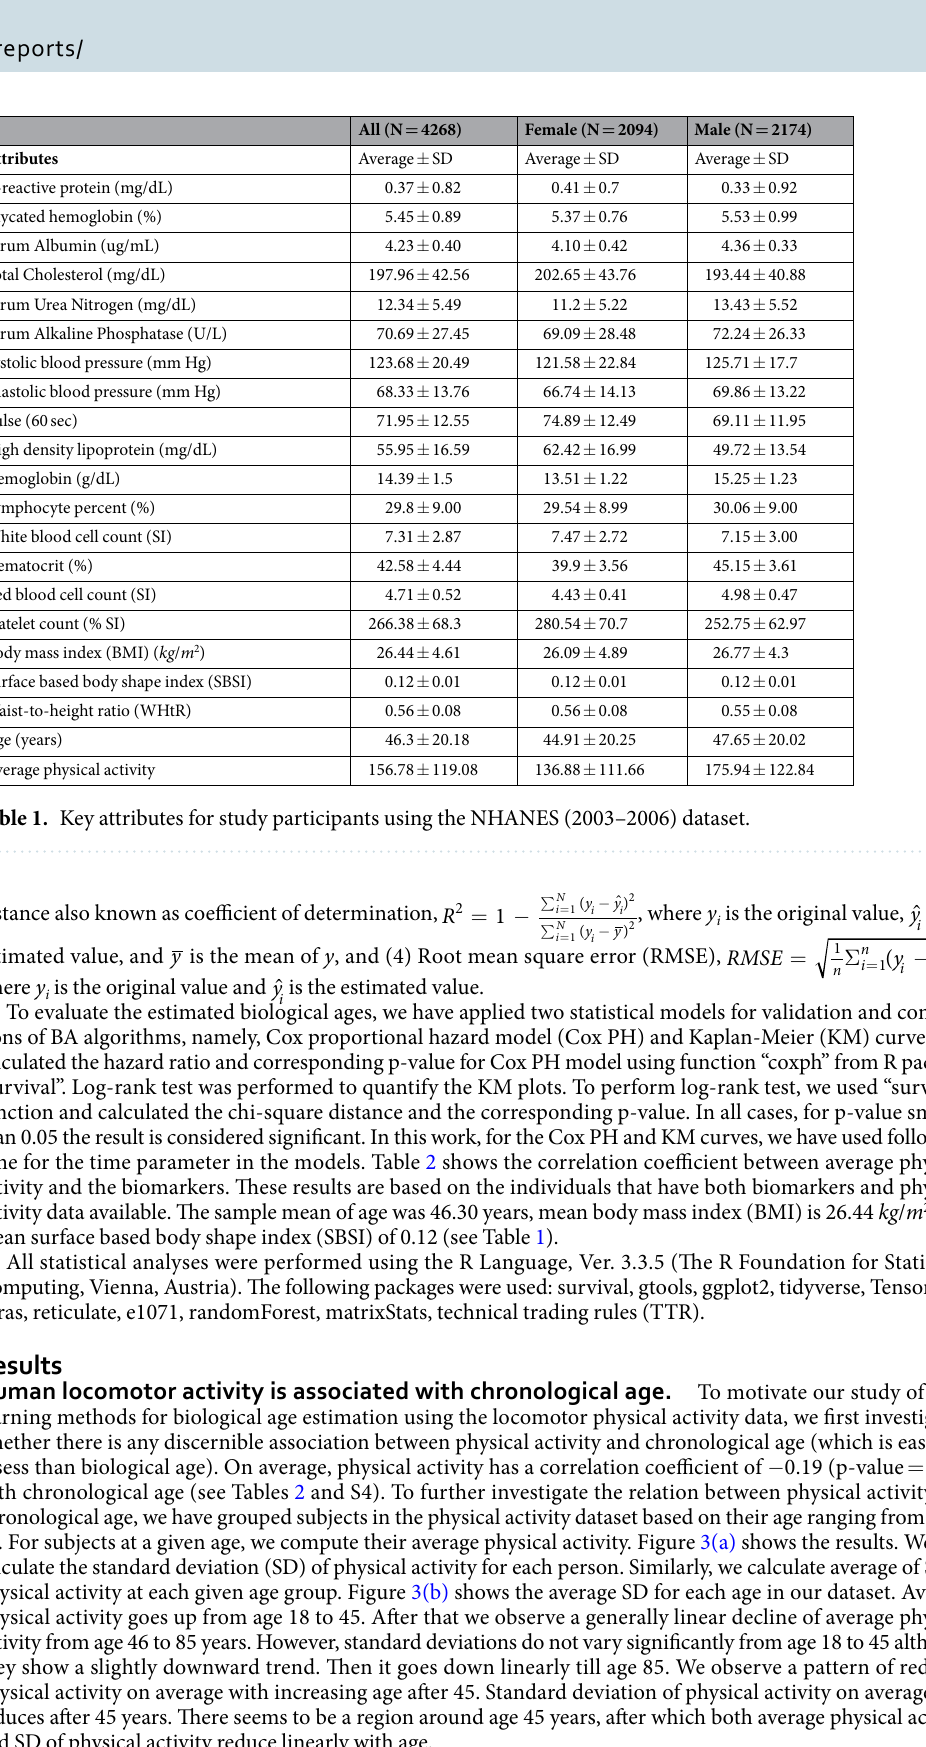
distance also known as coefficient of determination,